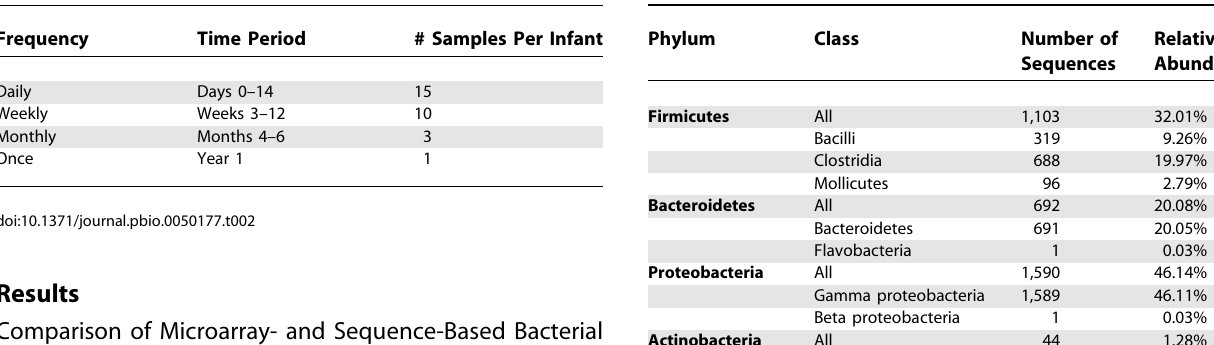
Table 2. Infant Stool Sample Collection